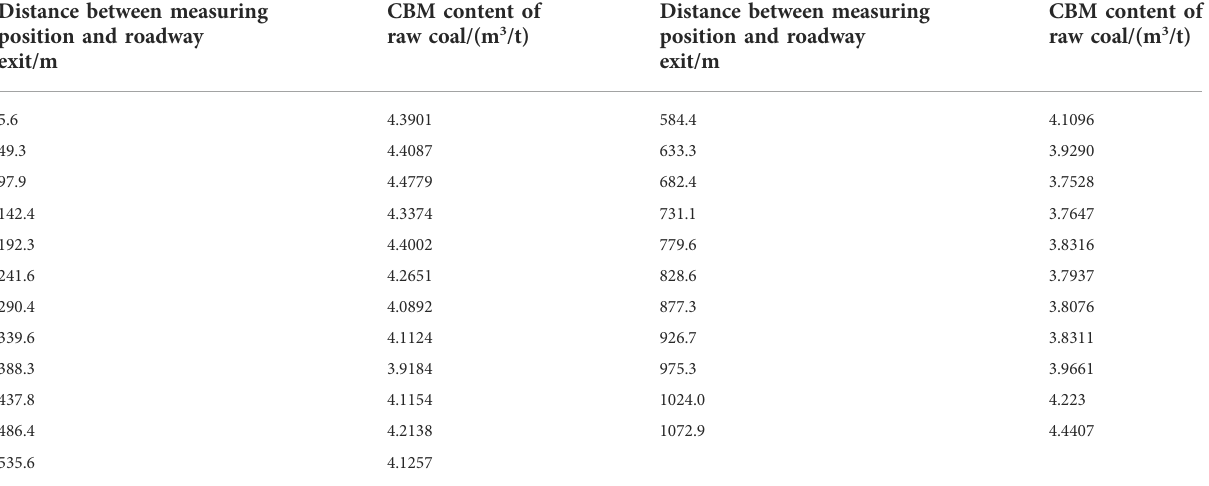
TABLE 2 Test results of basic parameters of CBM in tailentry #1303. Distance between measuring position and roadway exit/m